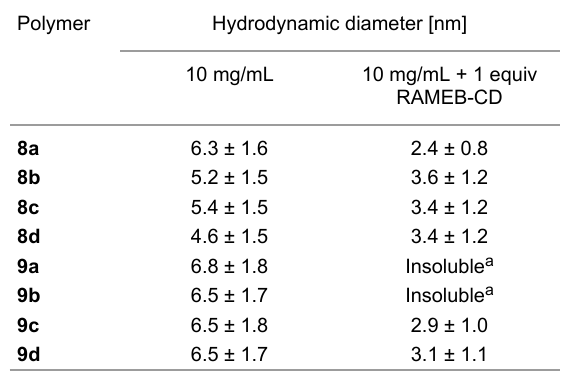
Table 3: Number averaged hydrodynamic diameters of the polymers and the supramolecular complexes with RAMEB-CD in water at 10 °C.